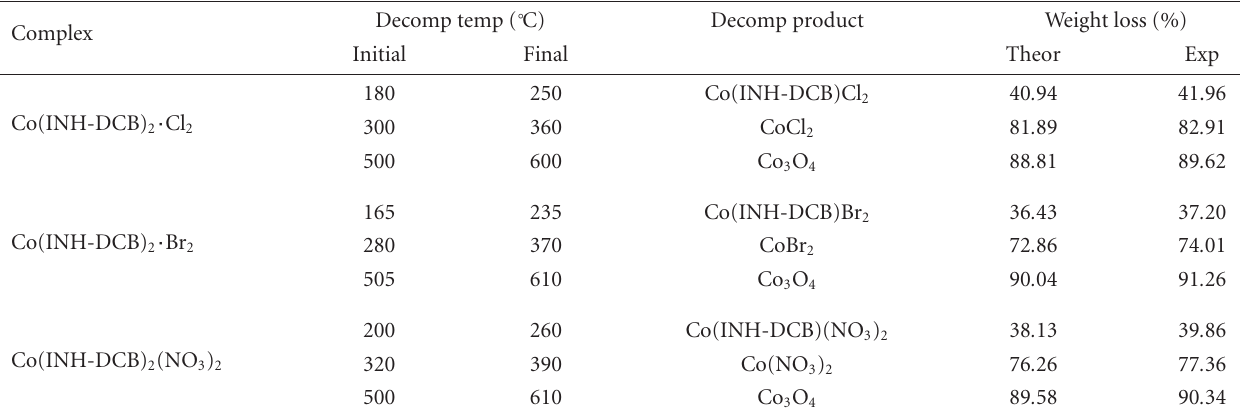
Table 5: Thermoanalytical results obtained for Co 2+ of INH-DCB.